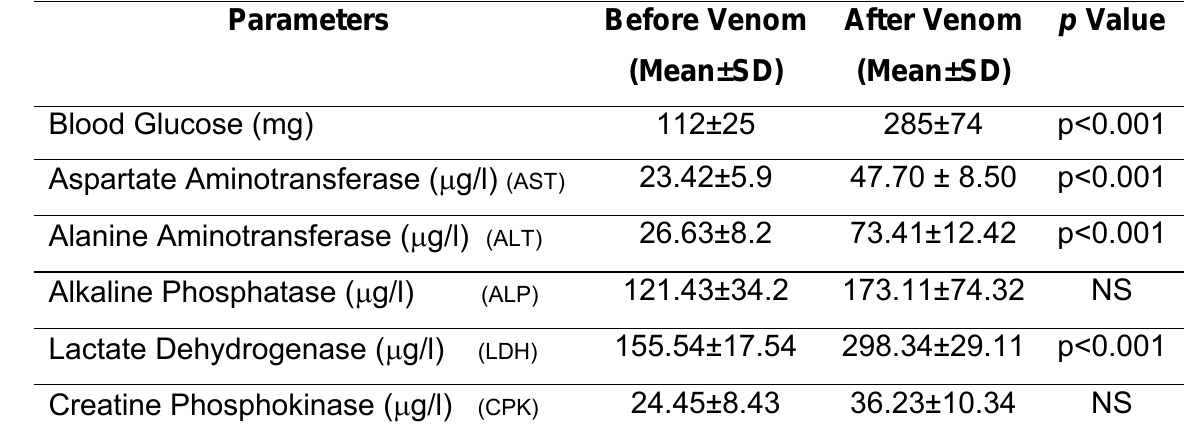
Table 1. Comparison of various biochemical parameters before and three hours after venom injection into experimental